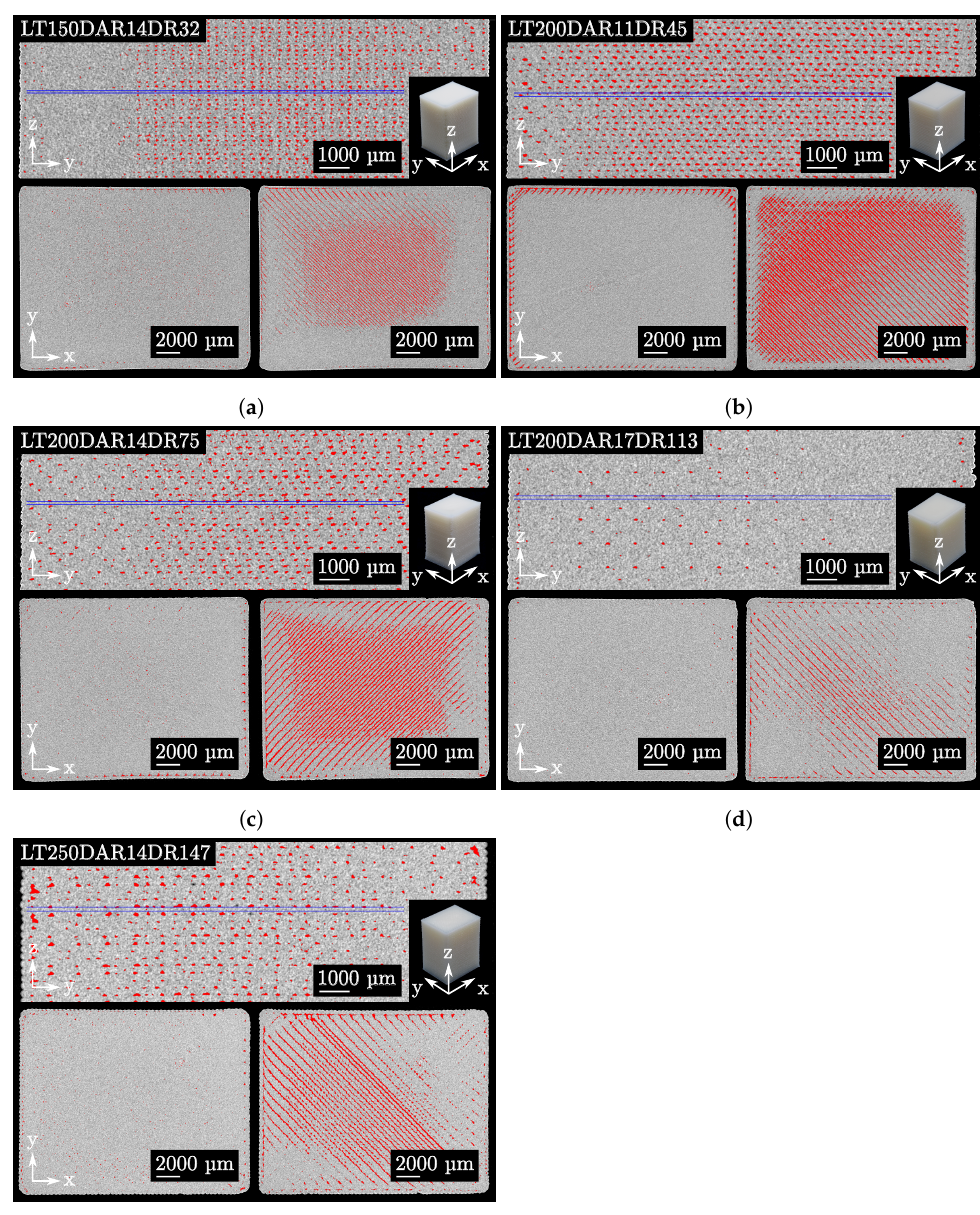
Figure 6. Slice images of the specimens with the specific parameter sets from Table 2. The left bottom corner shows a slicing plane within a layer, while the right corner shows a slicing plane between two layers. The top shows a slicing plane through multiple layers. The two slicing planes at the bottom are marked with two blue lines in the upper slicing plane. Porosity is coloured red. ( a – e ): The five different parameter